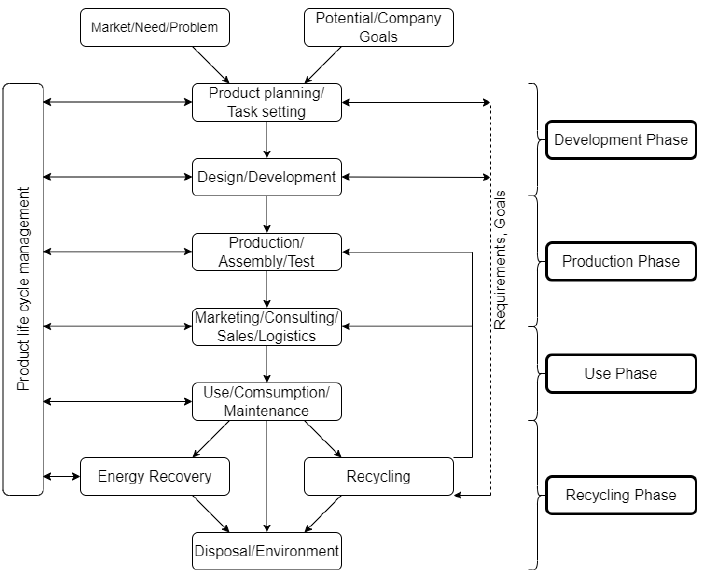
Figure 1. Life cycle of a product [6,9].